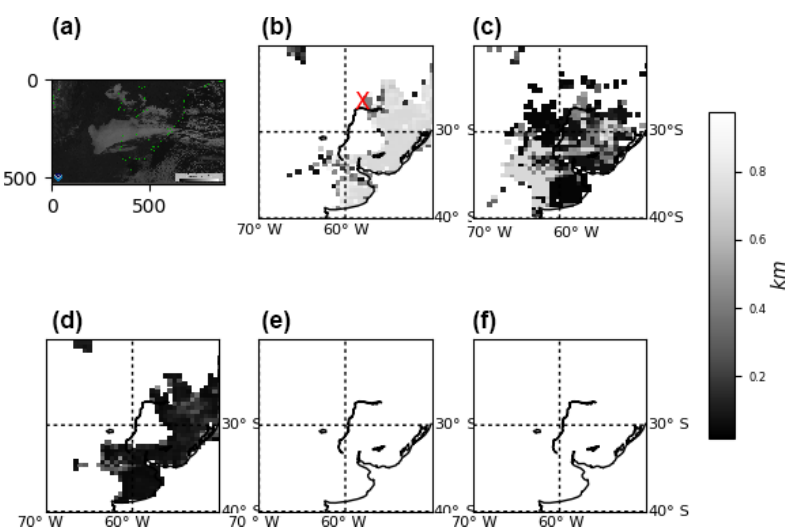
Figure 16. On 30 June 2007 at 12:00UTC, comparison of the different configurations of the diagnostics of mean fog visibility (in 1h) to the satellite image from GOES-12 (a) at the same time in the visible channel (courtesy of NOAA-CLASS), default vis3vars1 (fogvisibility = 3, fogvars = 1; b ), vis3vars2 (c) , vis1vars1 (d) , vis2vars1 (e) , and vis2vars2 (f)